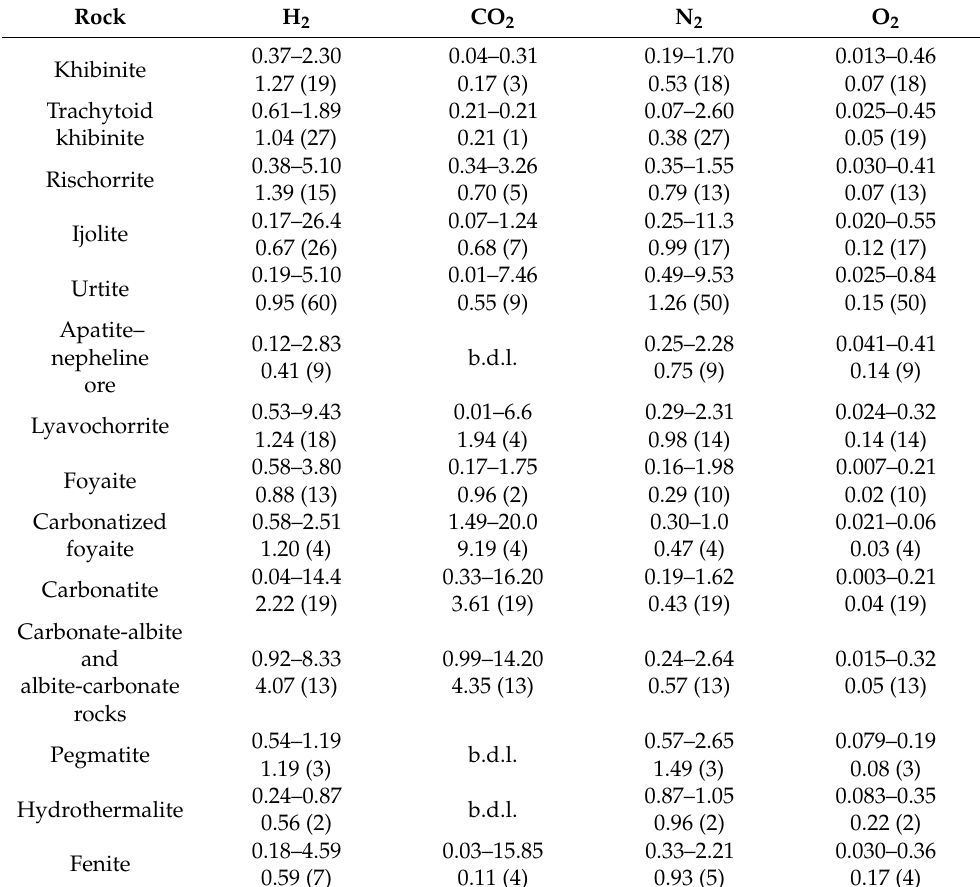
Table 2. Concentrations of occluded gases in the Khibiny massif {min-max/median (number of analyses)}, cm 3